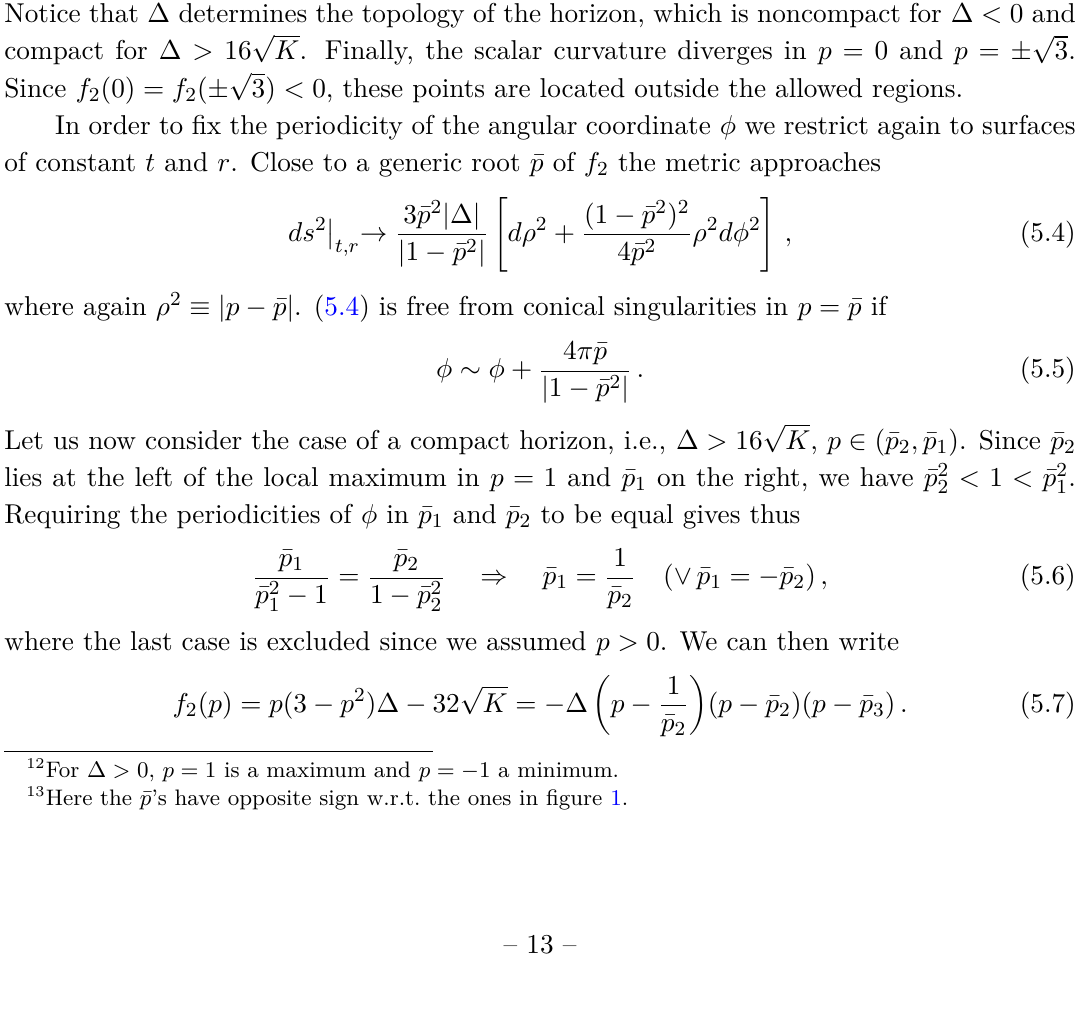
√ K , (b) ∆ = − 16 over the vertical 2